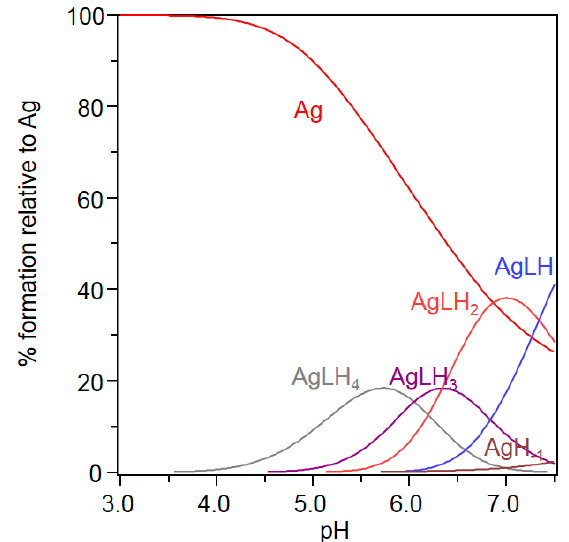
Figure 5. Species distribution of Ag + complexes with Ctr1 (1-14) (L). Ag + /Ctr1 (1-14) = 0.9; the analytical concentration of Ctr1 (1-14) is 5 × 10 − 4 mol dm − 3 .